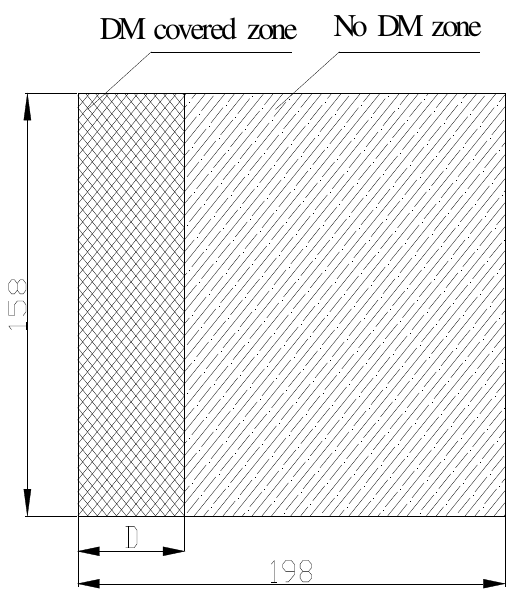
Figure 8. Short edge linear source.